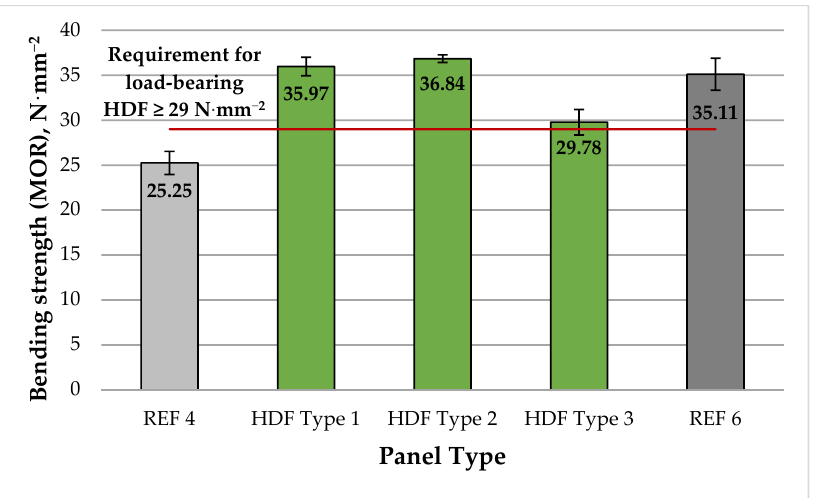
Figure 5. Bending strength (MOR) of HDF panels produced. REF 4: 4% UF resin; HDF Type 1: 4% UF resin and 4% ALS; HDF Type 2: 4% UF resin and 6% ALS; HDF Type 3: 4% UF resin and 8% ALS; and REF 6: 6% UF resin. (Error bar represents the standard deviation, and the red line represents the EN 622-5 standard requirement for panels for use in load-bearing applications [102].). The HDF panels exhibited MOR values ranging from 25.25 to 36.84 N·mm − 2 . Accord- ing to [106], MOE and MOR values of HDF panels are strongly correlated with the fiber